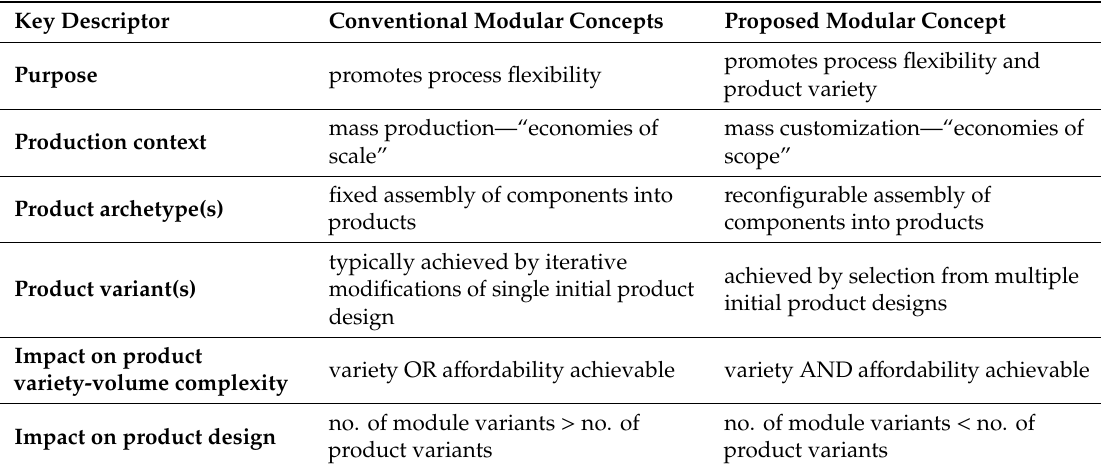
Table 2. Product modularization opportunities in the context of enhanced product variety during mass